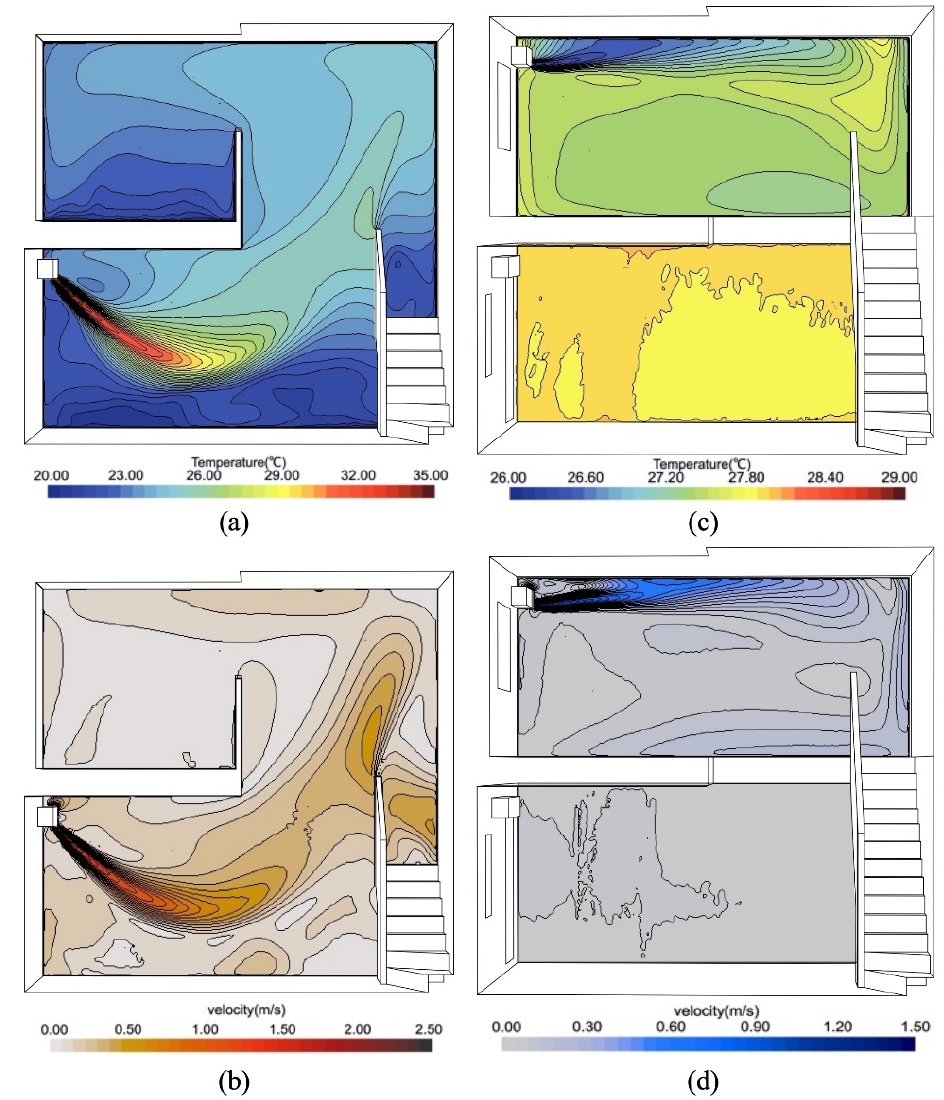
Figure 7. CFD analysis results: ( a ) Y -axis 1.5 m, temperature distribution; ( b ) Y -axis 1.5 m, air velocity distribution; ( c ) Y -axis 3.27 m, temperature distribution; ( d ) Y -axis 3.27 m, air velocity distribu-